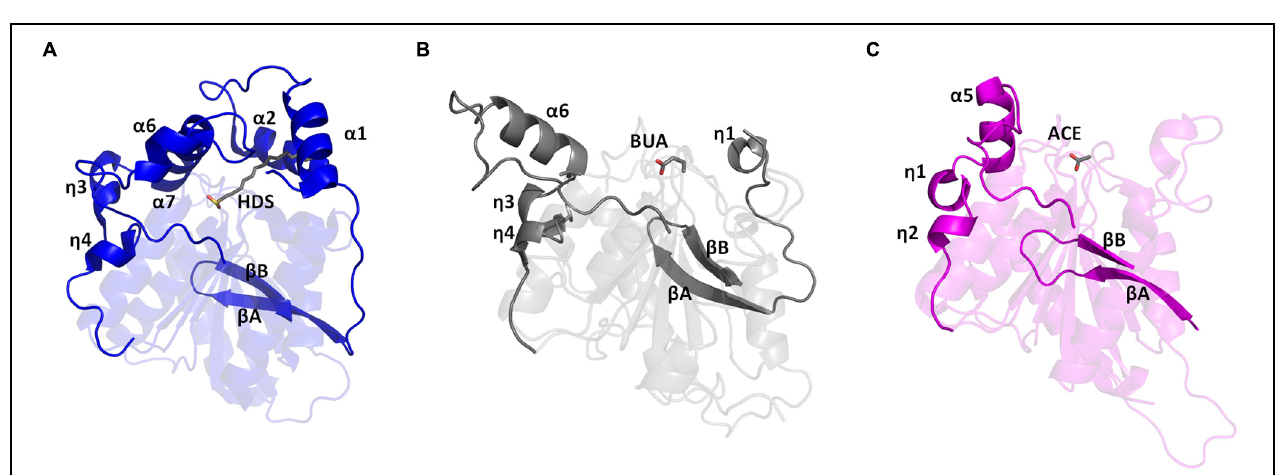
FIGURE 3 | Cartoon diagrams showing the protein structures of (A) AaEst2 (blue), (B) TtEst2 (gray) and (C) LpEst (magenta) in the same orientation. The regions which form the ‘cap’ domain in AaEst2 and restrict the carboxyl and alcohol binding sites in TtEst2 and LpEst are highlighted and the secondary structure elements are labeled. The carboxyl reaction products in TtEst2 and LpEst and the tetrahedral reaction intermediate analog in AaEst2 are shown as stick models.